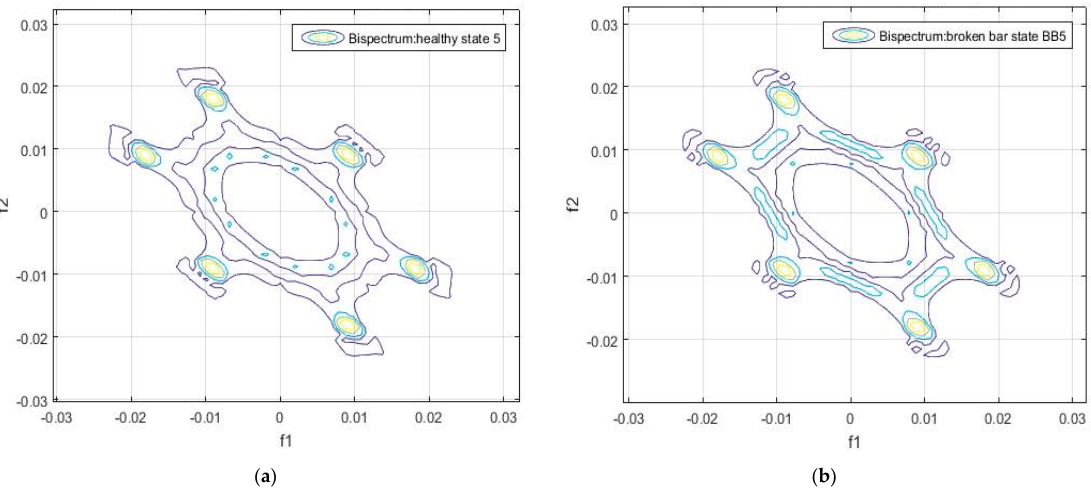
Figure 7. Contour of the bispectrum of the motor flux signal: ( a ) Sample 5 of the healthy motor and ( b ) Sample 5 of the damaged motor.